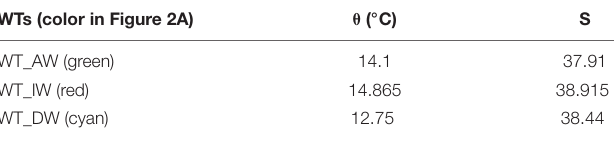
TABLE 1 | Properties of Water Types (WTs) for AW, IW, and